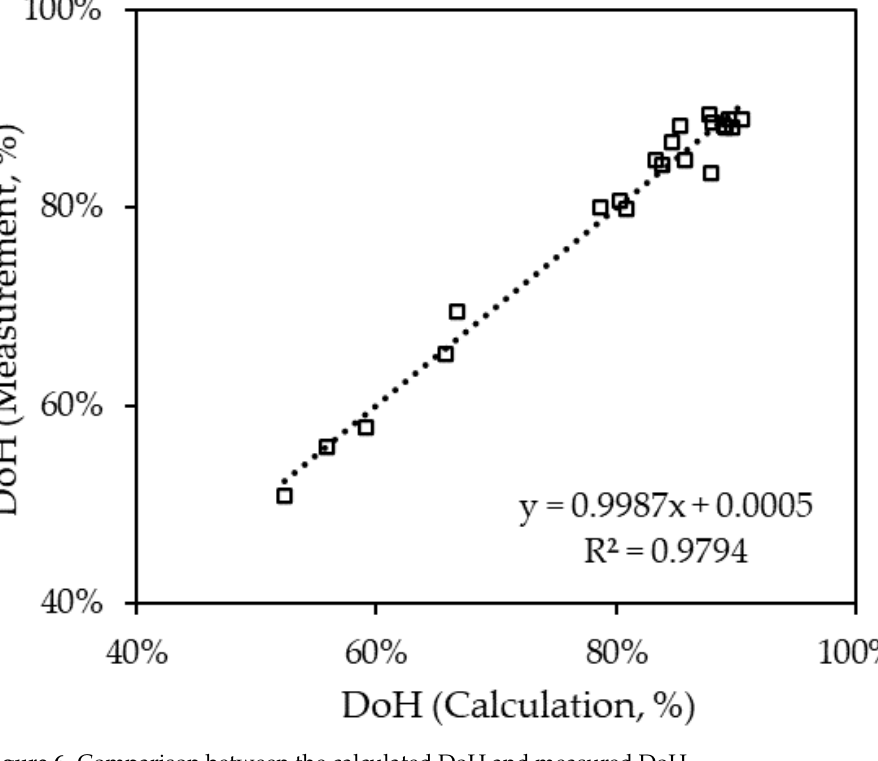
Figure 6. Comparison between the calculated DoH and measured DoH.